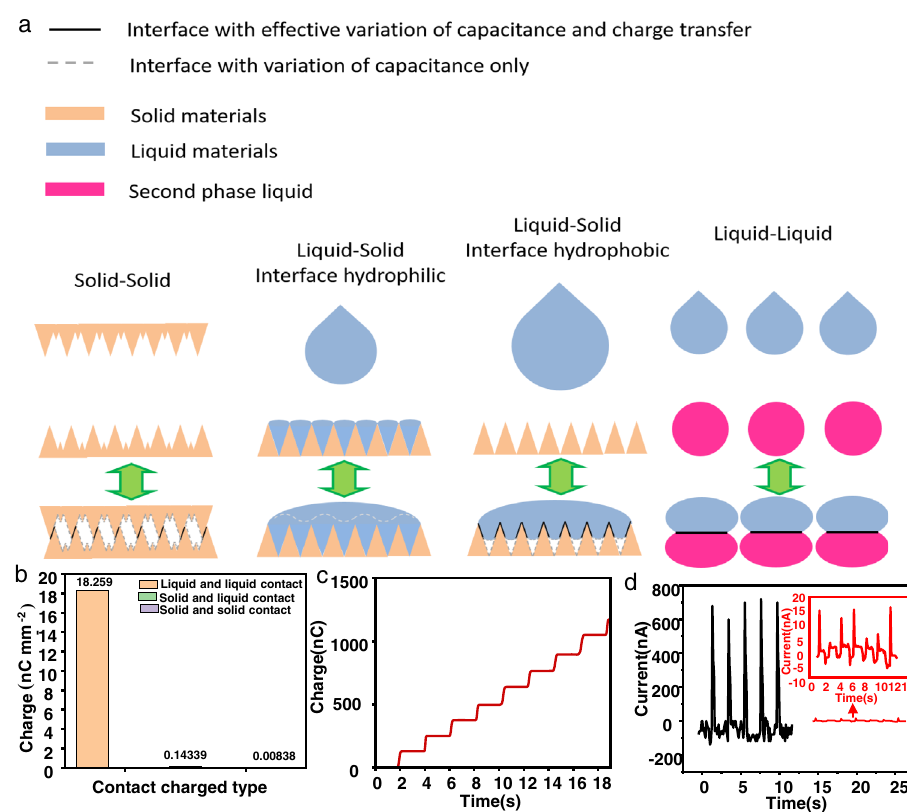
Fig. 3 | Interface comparison of liquid – liquid interface, liquid – solid interface, and solid – solid interface. a Solid – solid, solid – liquid, and liquid – liquid interface contact-separation mechanism analysis results. b Comparison of surface charge